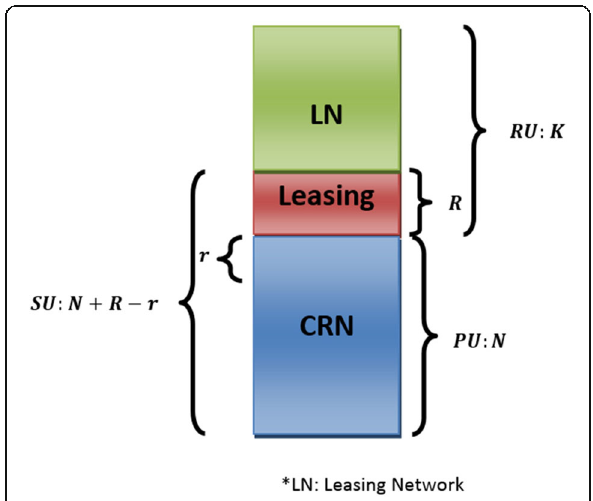
Fig. 3 Resource distribution and allocation for the dynamical and anticipated leasing